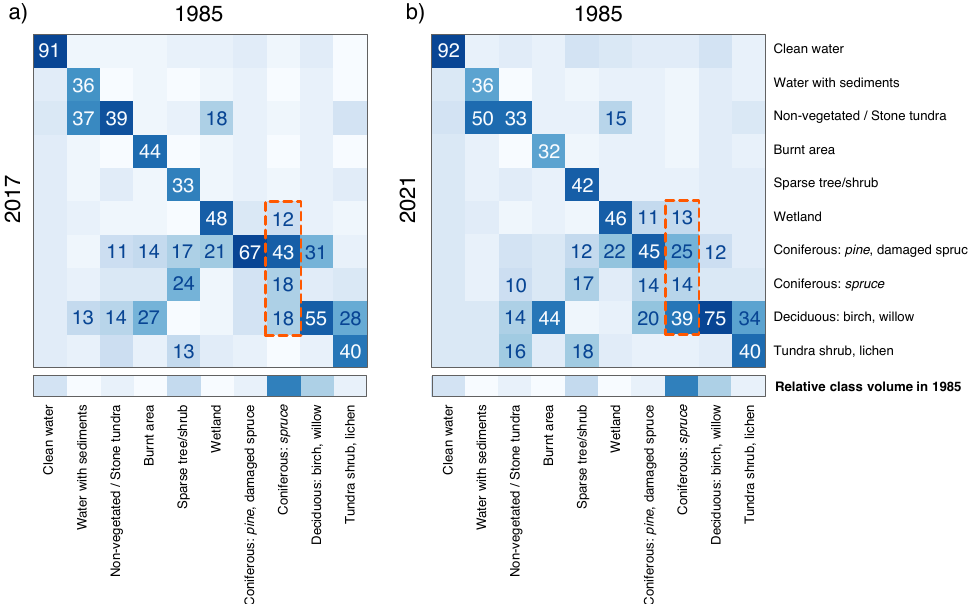
Figure 10. The heat-map plots show contingency tables for land cover classes between 1985 and ( a ) 2017, and ( b ) 2021. The data are normalised per column (to individual class populations of 1985), which permits assessing how each class of 1985 was classified in a later year. For example, the dash-line selections show that out of all Coniferous (spruce) that was detected in 1985, 18% was classified as Coniferous (spruce) again in 2017 (14% in 2021), 43% as Coniferous (pine) (25%), 18% as Deciduous (39%) and 12% as Wetland (13% in